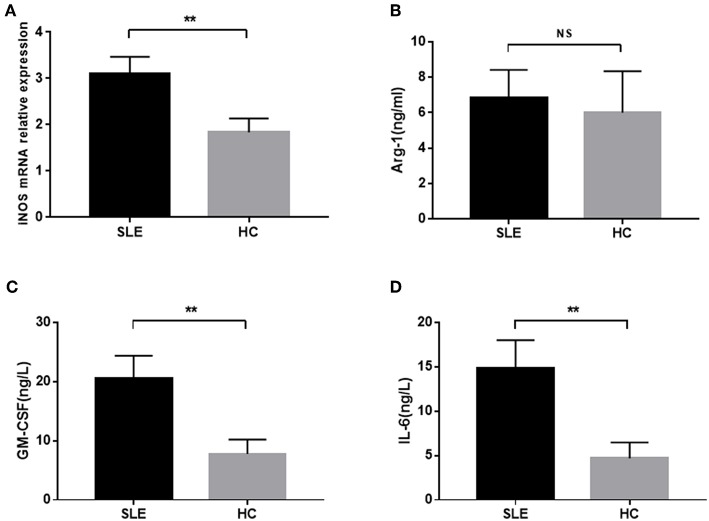
The concentration of iNOS mRNA, Arg-1, GM-CSF, and IL-6 in newly diagnosed SLE patients. (A) The level of iNOS mRNA in SLE patients was significantly higher than that in healthy controls. (B) Plasma level of Arg-1 was not significantly elevated in SLE patients. (C,D) The plasma levels of GM-CSF and IL-6 in SLE patients were significantly higher than those in healthy controls. **P < 0.01.